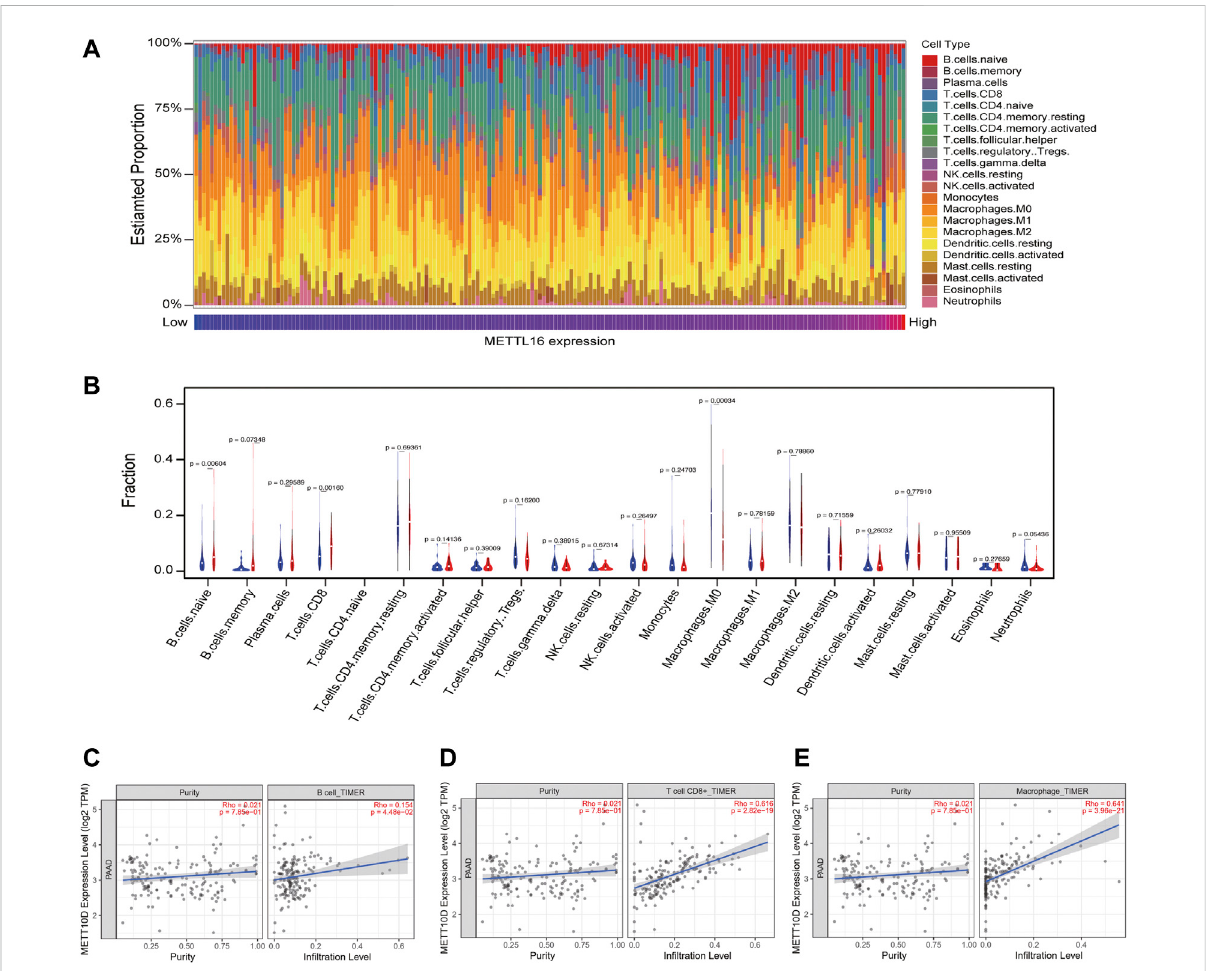
FIGURE 7 Correlation ofMETTL16 with tumor-in fi ltrating immune cellsinPDA. (A) Immune cell in fi ltrationpro fi les intheTCGA-PAAD cohort fordifferent METTL16 expression groups. (B) Analysis of differential tumor-in fi ltrating immune cells between the METTL16 low- (blue) and high-expression groups (red) using CIBERSORT. (C – E) Subsequent con fi rmation of the relationship between METTL16 expression and tumor-in fi ltrating B cells (C) , CD8 + T cells (D) , and macrophages (E) via the TIMER